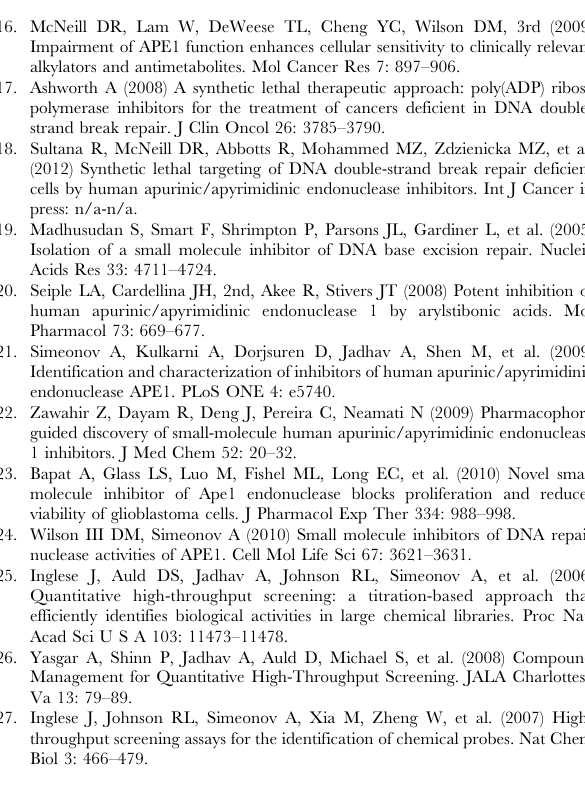
trends. Table S1 HTS hits which displayed inhibition in the electro- phoretic separation based